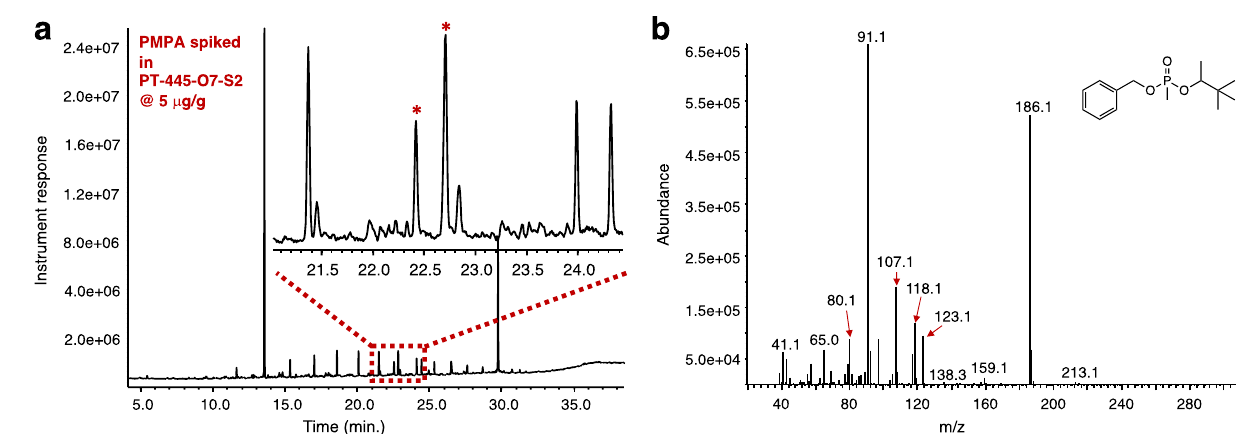
Figure 5. GC–MS analysis on soil sample PT-S2* containing PMPA at ~ 5 μg/g concentration. ( a ) Gas chromatogram showing the formation of the benzyl product BPMPA (indicated by both asterisks); ( b ) mass spectrum of